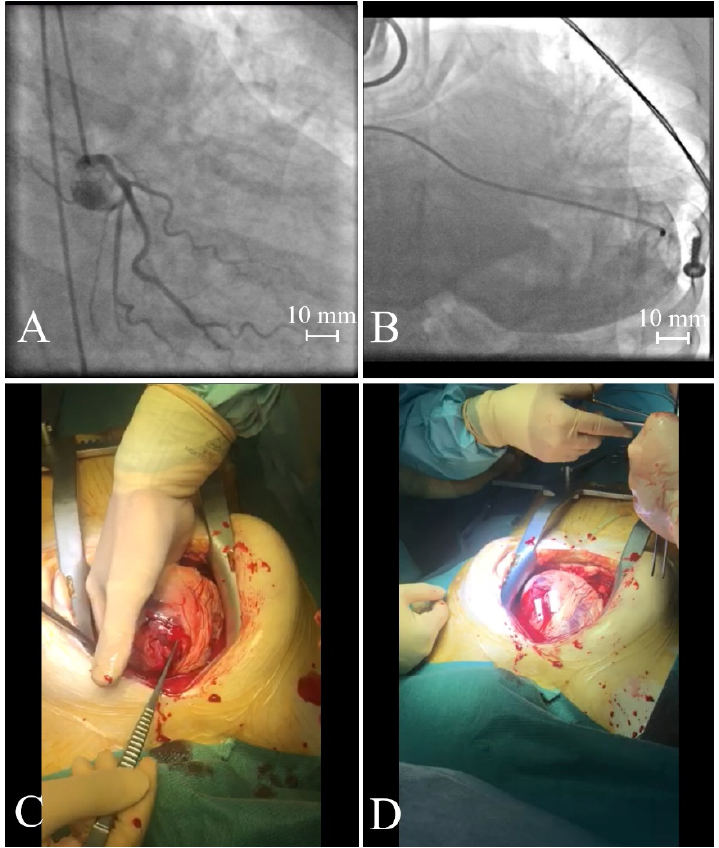
Figure 3. A patient with blowout type of free wall rupture. The acute ostial occlusion of left anterior descending artery ( A ). Pericardiocentesis ( B ). A blowout type of anterior wall rupture ( C ) sutured by a cardiac surgeon ( D ).